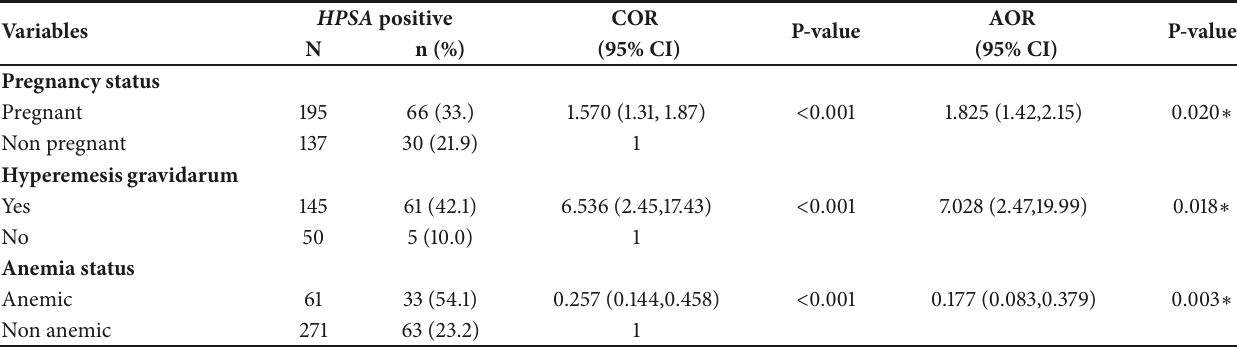
Table 3: Multivariate logistic regression showing adjusted odds ratio between H. pylori infection and associated risk factors among women of childbearing ages participated in the study in selected health centers, Addis Ababa, Ethiopia, April to October 2015 (n=332).